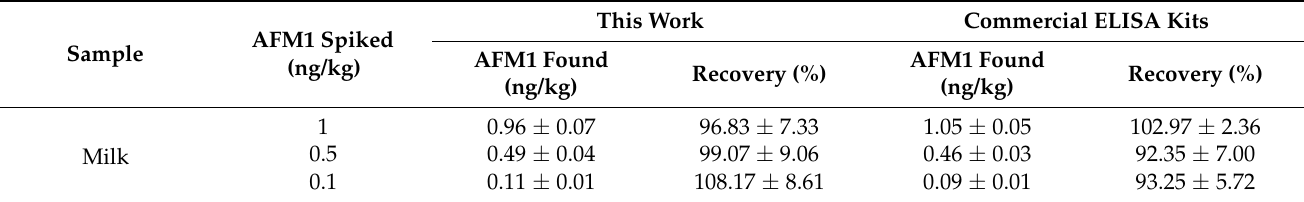
Table 2. Recoveries of AFM1 in samples ( n =